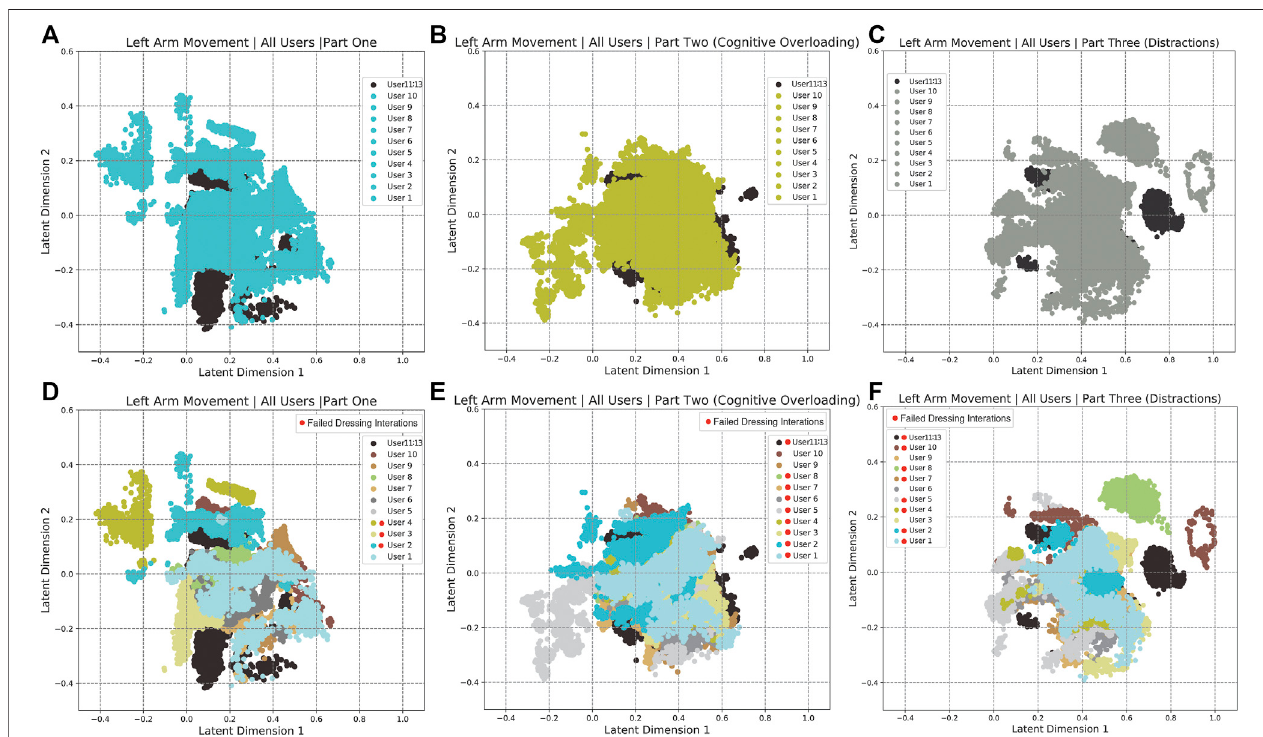
FIGURE11| SeparatedLatentSpacerepresentationoftherightarmmovementsforPartOne (A,D) ,PartTwo (B,E) andPartThree (C,F) . (Panels A – C) showthe 2-Dlatentspacerepresentationforalltheparticipants. (PanelsD – F) showstherepresentationoftenindividualparticipants.Theparticipantsmarkedwithareddotinthe legend had dressing failures in their dressing iterations.